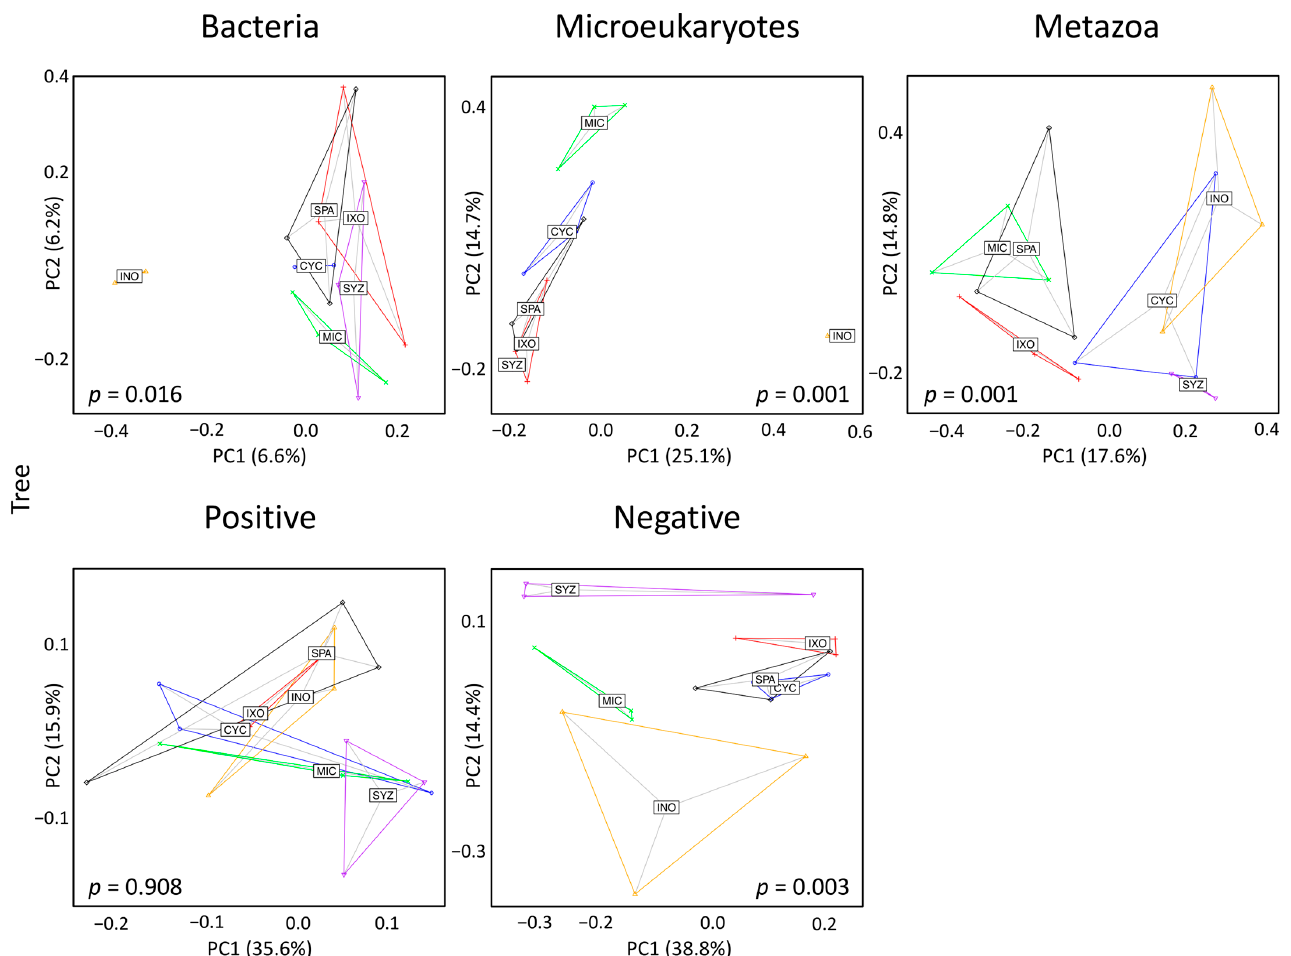
Figure 6. Principal coordinate analysis in the tree stage. Bray–Curtis dissimilarities between samples were used for these analyses. Each dot corresponds to one sample. Labels of plant species are displayed at the barycenters of dots. CYC: Cyclophyllum barbatum , INO: Inocarpus fagifer , IXO: Ixora mooreensis , MIC: Miconia calvescens , SPA: Spathodea campanulata , SYZ: Syzygium malaccense .